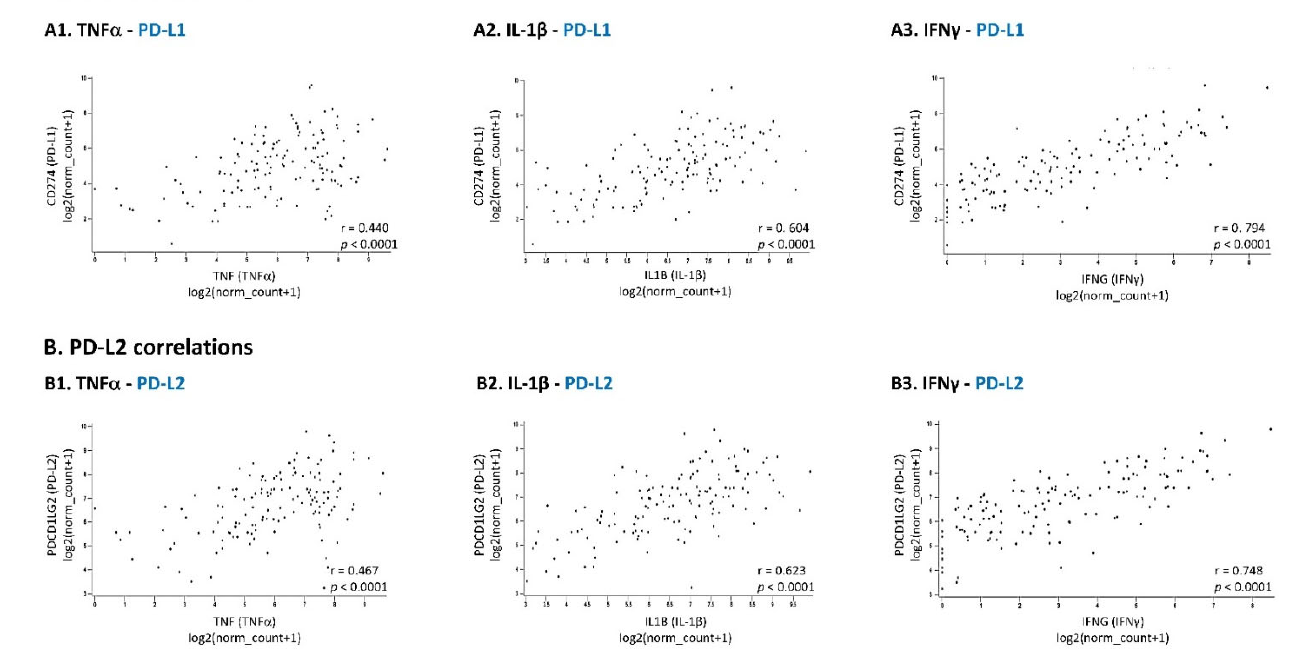
Figure 3. TCGA dataset analyses of basal-like breast cancer patients reveal a highly significant correlation between the expression of TNF α , IL-1 β and IFN γ and the expression of PD-L1 and PD-L2. The TCGA breast cancer dataset was used to identify correlations in gene expression patterns in basal-like patients. n = 141. ( A ) Associations of TNF α ( A1 ), IL-1 β ( A2 ) and IFN γ ( A3 ) with PD-L1. ( B ) Associations of TNF α ( B1 ), IL-1 β ( B2 ) and IFN γ ( B3 ) with PD-L2. Correlation coefficients and p values are demonstrated in the Figure. Statistical analyses were performed as described in Section